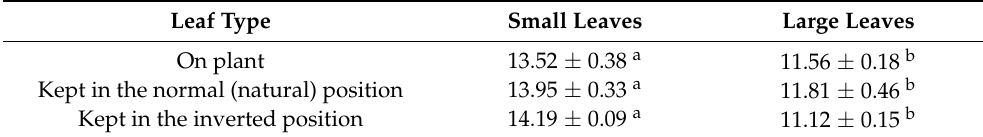
Table 1. Proanthocyanidins content ( µ M/g DW) in K. blossfeldiana leaves on the plant and in leaves detached and kept 4 days in the natural position or kept 4 days in the inverted position. Mean results in columns ± standard deviation (SD) followed by the same letter were not significantly different ( p < 0.05) according to Tukey’s test. Leaf Type Small Leaves Large Leaves On plant Kept in the normal (natural) position